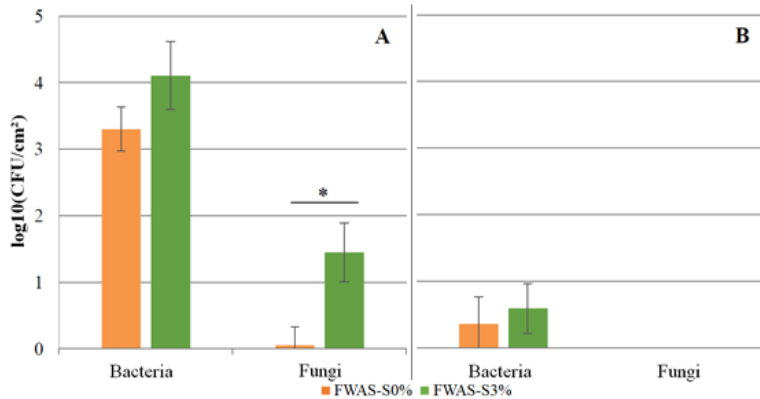
Figure 4. Colony Forming Units (average ± standard deviation; three independent assays in triplicate) per cm² of adhesive obtained by sampling the surface of undried specimens (A) or specimens dried at 100 °C